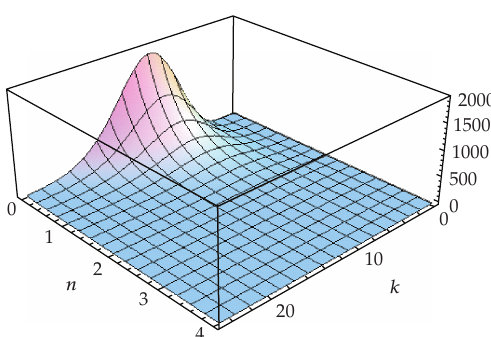
Figure 5: The graphic of the hyperspherical function with the constant radius r (cid:7) 1 and for the degrees of freedom 0 < n ≤ 4 and 0 < k ≤